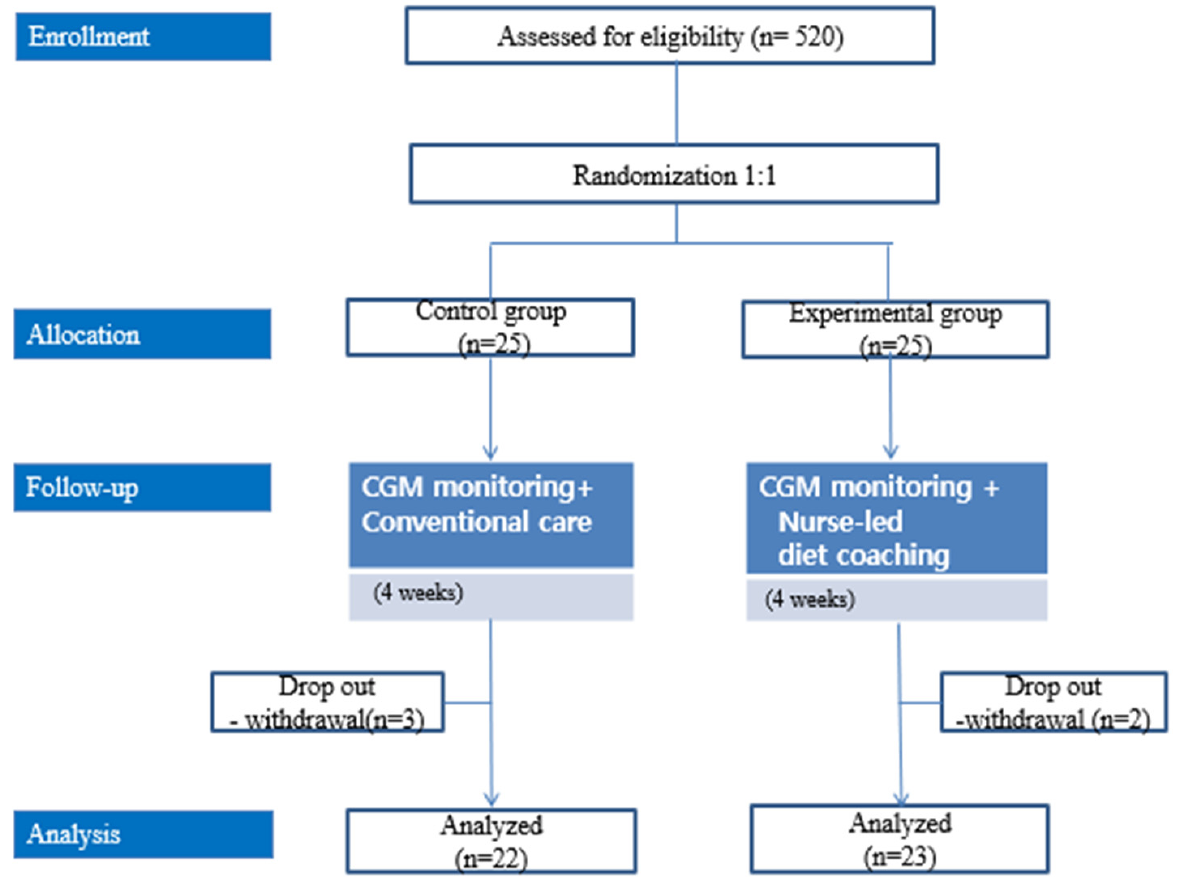
Figure 1. Study flow.